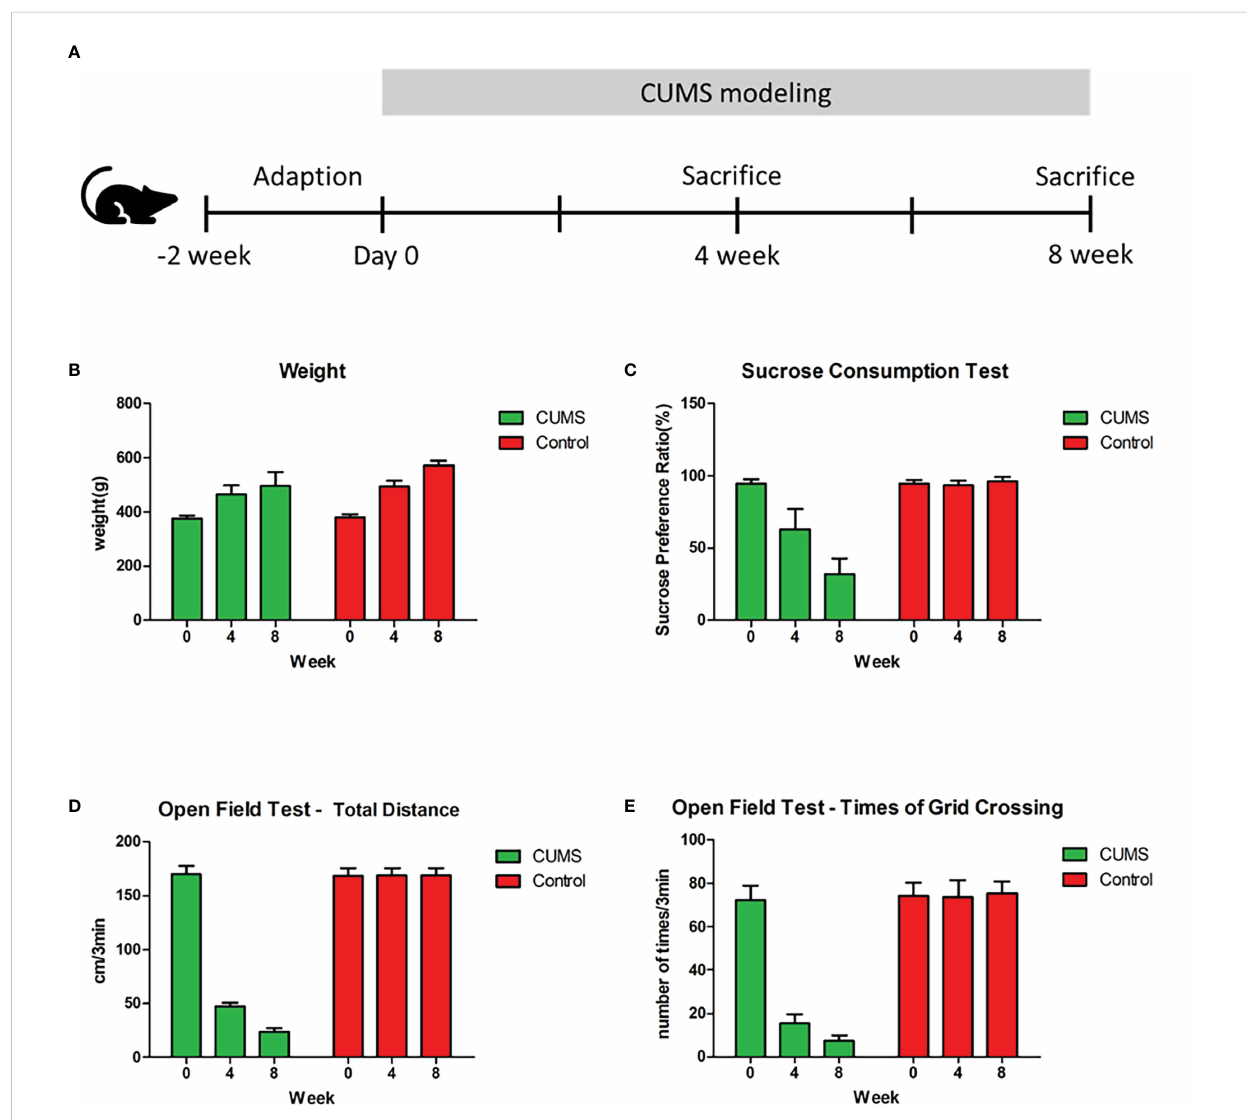
FIGURE 1 Experimental Schema and behavioral results. (A) Schedule of experimental procedures. (B) Changes in weight among control, rats under 4-week CUMS, and rats under 8-week CUMS. (C) Changes in sucrose preference among control, rats under 4-week CUMS, and rats under 8-week CUMS. (D) Changes in total distance in the open fi eld test among control, rats under 4-week CUMS, and rats under 8-week CUMS. (E) Changes in times of grid crossing in the open fi eld test among control, rats under 4-week CUMS, and rats under 8-week